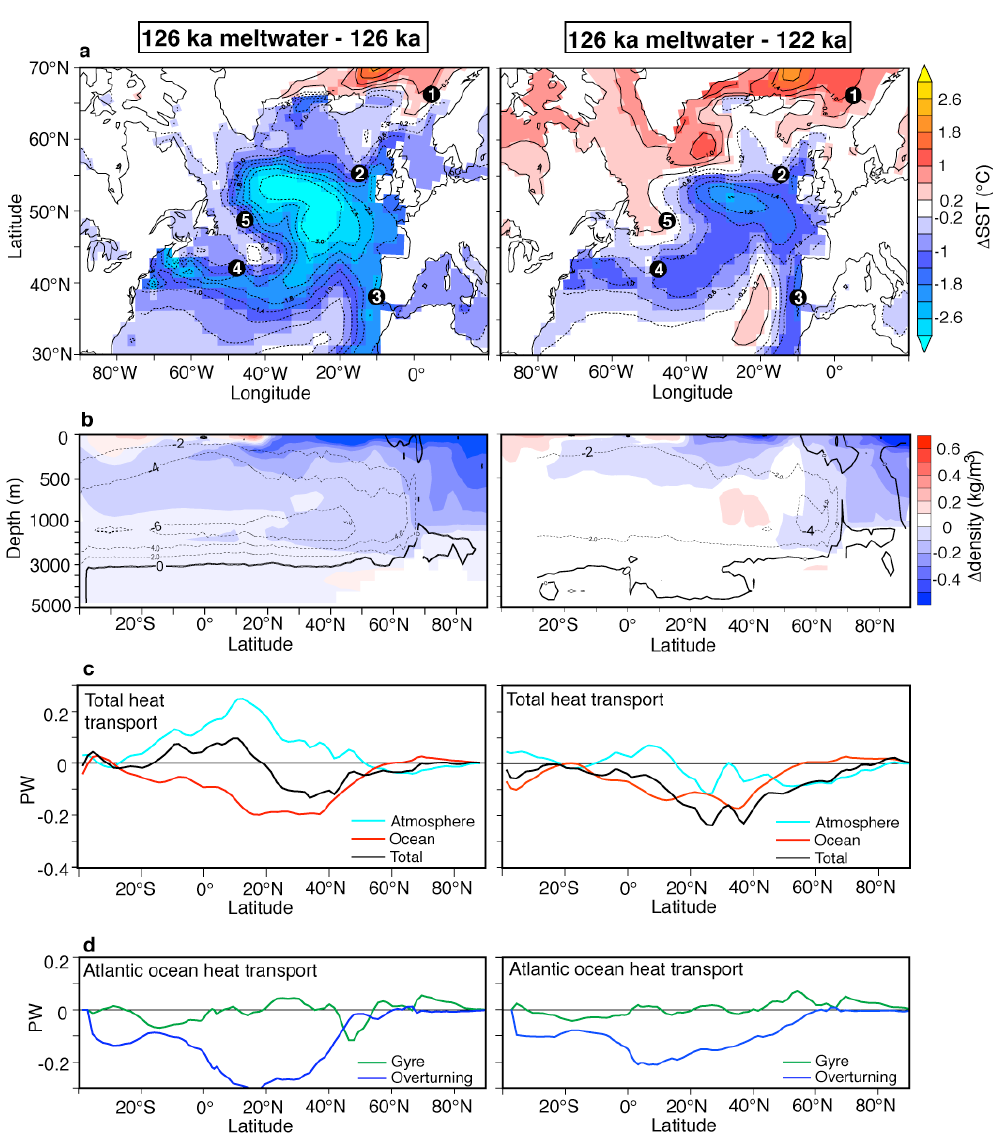
Figure 10: Modeled climate response to the northern input of meltwater ( left panel ) at 126 ka with and without meltwater, and ( right panel ) between 126 ka with meltwater input and 122 ka. Averaged outputs over the last 100 years of the simulations are presented. We only show the statistically significant differences at the 95% level using a student t-test on the interannual variability of the last 100 years of each simulation. (a) North Atlantic map of the mean annual SST anomalies. Black circles indicate the location of the northern sediment cores considered here: (1) MD95-2010 (Risebrobakken et al., 2006), (2) ODP 980 (Oppo et al., 2006), (3) MD95-2042 (Shackleton et al., 2002), (4) CH69-K09 (Cortijo et al., 1999), and (5) EW9302-JPC2 (Rasmussen et al., 2003a). (b) Atlantic annual mean zonal density (color scale) and overturning (2Sv contour lines, flow is clockwise around positive contour lines) anomalies. (c) Total heat transport (black line, 1PW=10 15 W), decomposed between the atmosphere (turquoise line) and the ocean (red line). (d) Atlantic Ocean heat transport decomposed into gyre (green line) and overturning (blue line) components.